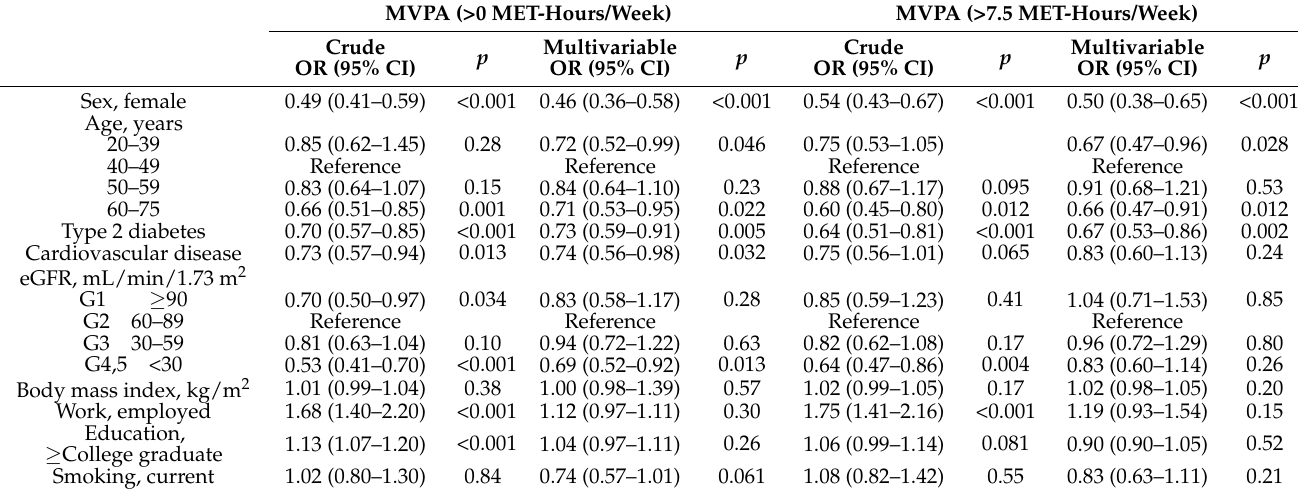
Table 2. Association between demographic, social, and health factors in nondialysis CKD and MVPA. MVPA (>0